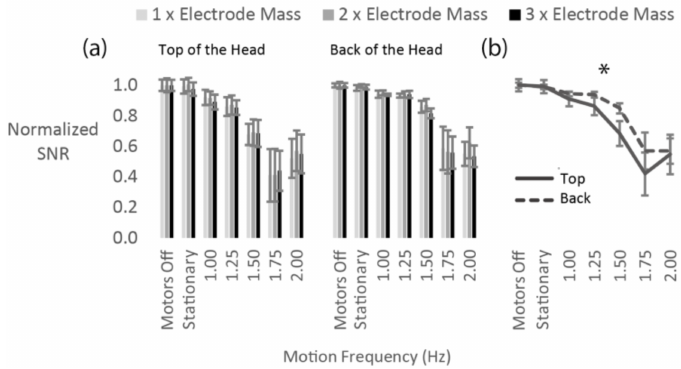
Figure 3. ( a ) Normalized signal to noise ratio (SNR) values during motion for each mass condition for electrodes on the top and the back of the head; ( b ) normalized SNR values averaged across all mass conditions for all frequencies for the top and the back of the head. There was no general effect of electrode mass on the SNR. There was a significant main effect of motion frequency and an interaction between head location and motion frequency. The plotted error bars represent the standard error of the